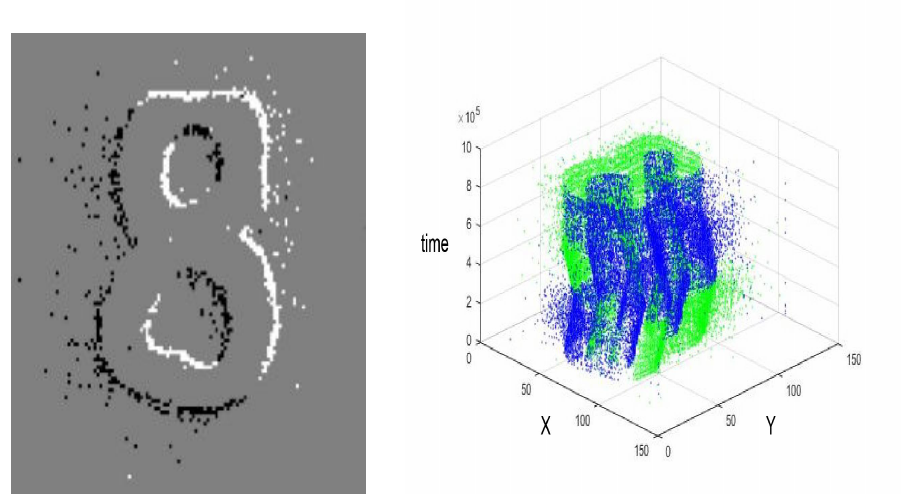
Figure 2. Left : captured histogram of events from neuromorphic vision sensors (ON = black events; OFF = white events). Right : Events temporal activity diagram from the